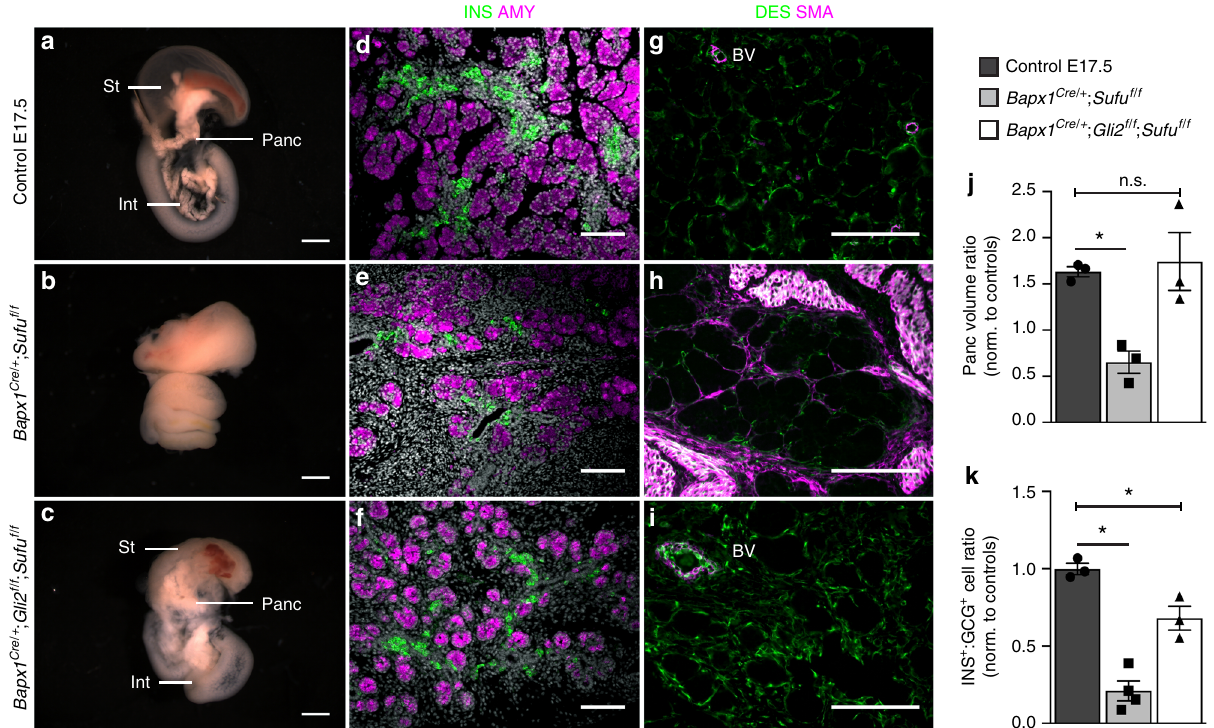
Fig. 4 Mesenchymal deletion of Gli2 ameliorates pancreatic defects in Sufu mesKOs. a – c Representative E17.5 control a , Bapx1 Cre/ + ; Sufu f/f mutant b , and Bapx1 Cre/ + ; Gli2 f/f ; Sufu f/f rescue gut c . St- Stomach, Int- Intestine, Panc- Pancreas. d – f Immunostaining for INS and AMY in control E17.5 d , Bapx1 Cre/ + ; Sufu f/f mutant e , and Bapx1 Cre/ + ; Gli2 f/f ; Sufu f/f rescue pancreata f . g – i Co-staining for DES and SMA in E17.5 control g , Bapx1 Cre/ + ; Sufu f/f mutant h , and Bapx1 Cre/ + ; Gli2 f/f ; Sufu f/f pancreatic mesenchyme i . BV- Blood vessel. j Comparison of the ratios in E17.5 pancreatic volume between Bapx1 Cre/ + ; Sufu f/f mutants and their controls vs. Bapx1 Cre/ + ; Gli2 f/f ; Sufu f/f rescues and their controls ( n = 3 samples of each genotype). k Comparison of INS + to GCG + cell ratios in Bapx1 Cre/ + ; Sufu f/f and Bapx1 Cre/ + ; Gli2 f/f ; Sufu f/f pancreata, normalized to controls ( n = 3 control and rescue samples, n = 4 mutant samples). Data are means ± SEM. n.s. denotes not signi fi cant, * denotes p < 0.05 by Student ’ s un-paired, two tailed t -test. Scale bars: Whole mount- 1 mm, Immuno fl uorescence- 100 µ